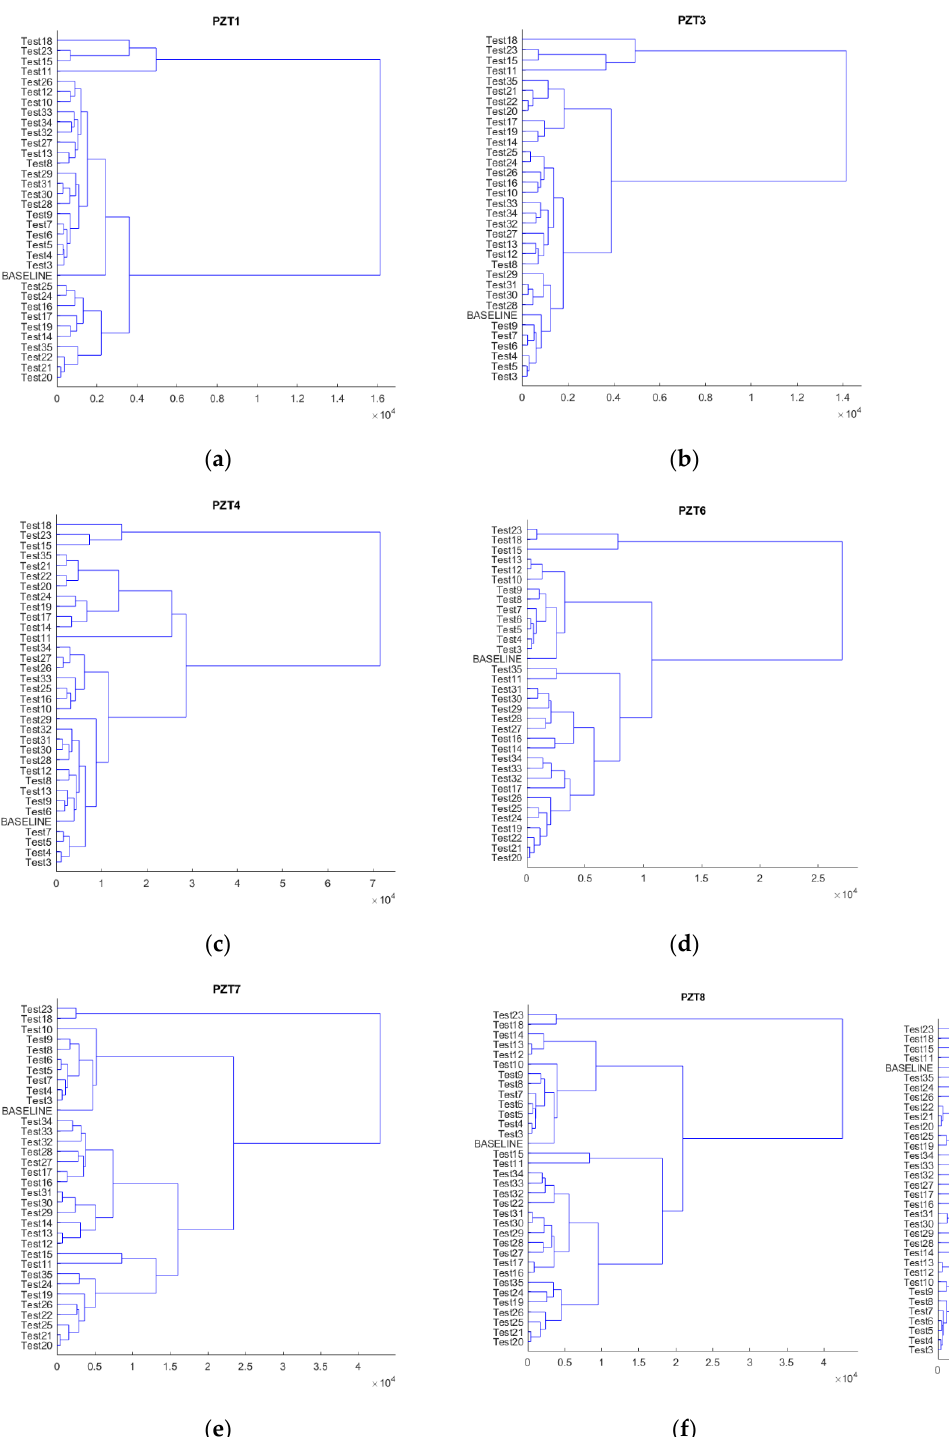
Figure 7. Hierarchical trees considering all tests. ( a ) PZT1, ( b ) PZT3, ( c ) PZT4, ( d ) PZT6, ( e ) PZT7, ( f ) PZT8, ( g ) PZT9 .